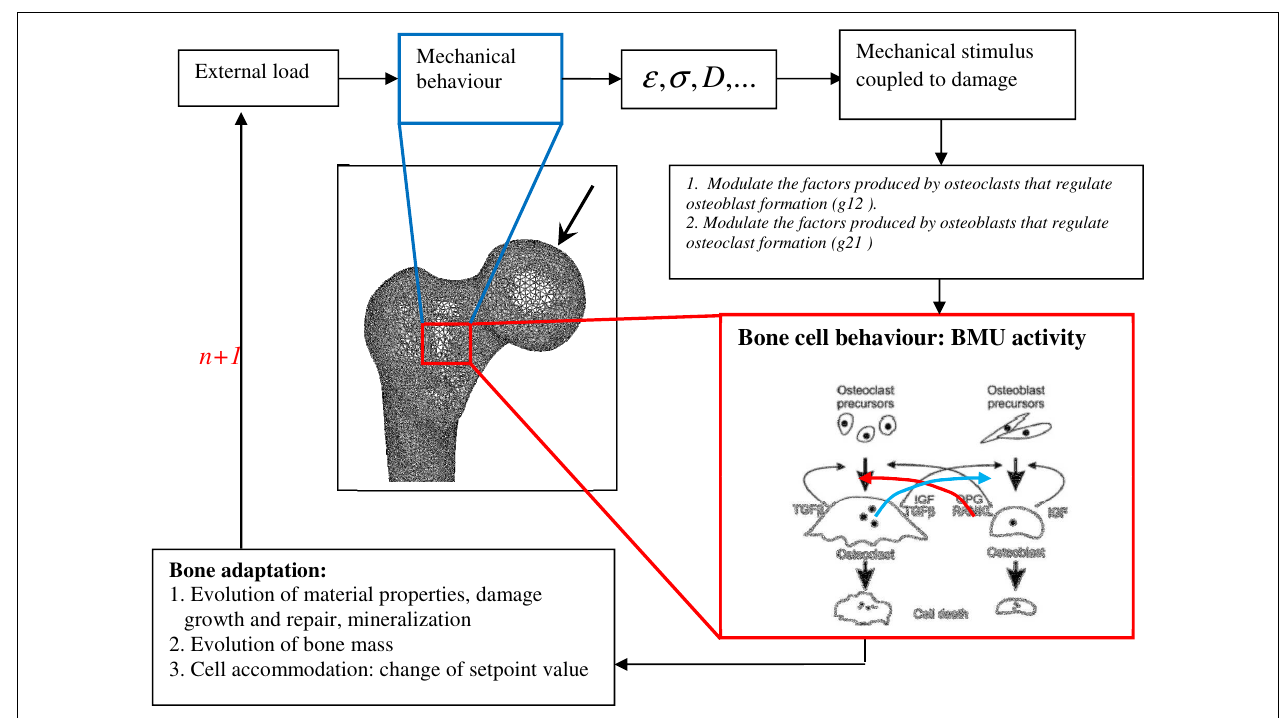
every bone site.The stimulus is converted into signals, which control the osteoblast and osteoclast interactions. Bone formation and removal is performed by competition between osteoblast and osteoclast growth at the given bone